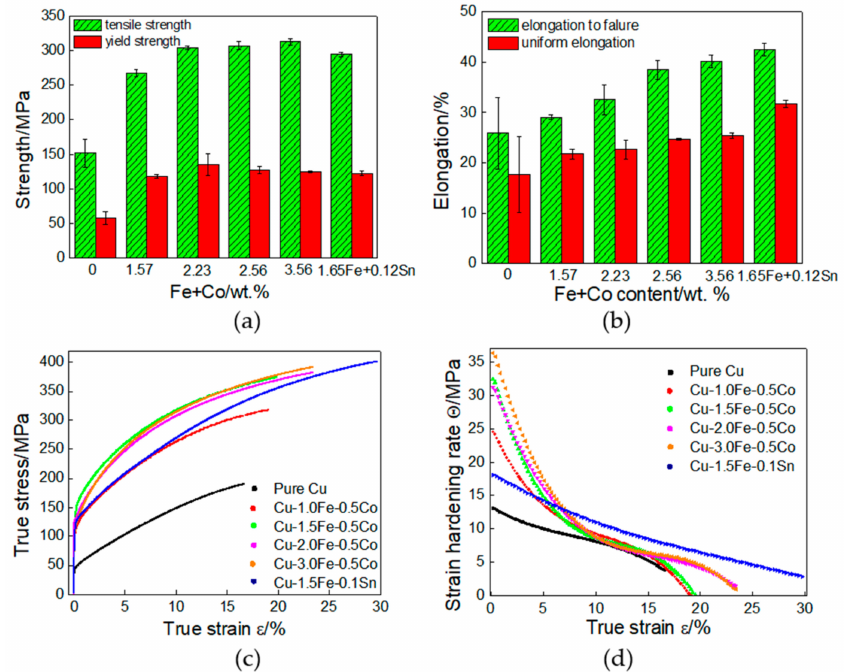
Figure 12. Comparison of room-temperature tensile behavior for the samples. ( a ) Ultimate tensile stress σ UTS , yield tensile stress σ s ; and ( b ) Elongation to failure δ f and uniform elongation δ u of the as-cast samples (with standard deviation bars). All states were tested in quadruplicate and the error bars plotted in ( a , b ) represent the full range of scatter amongst the four tests for each state examined; ( c ) Tensile true stress-strain curves converted from the engineering stress-strain curves by using Standard textbook equations; ( d ) Strain-hardening curves. Strain-hardening rate Θ = d σ /d ε , where σ and ε are true stress and true strain, respectively